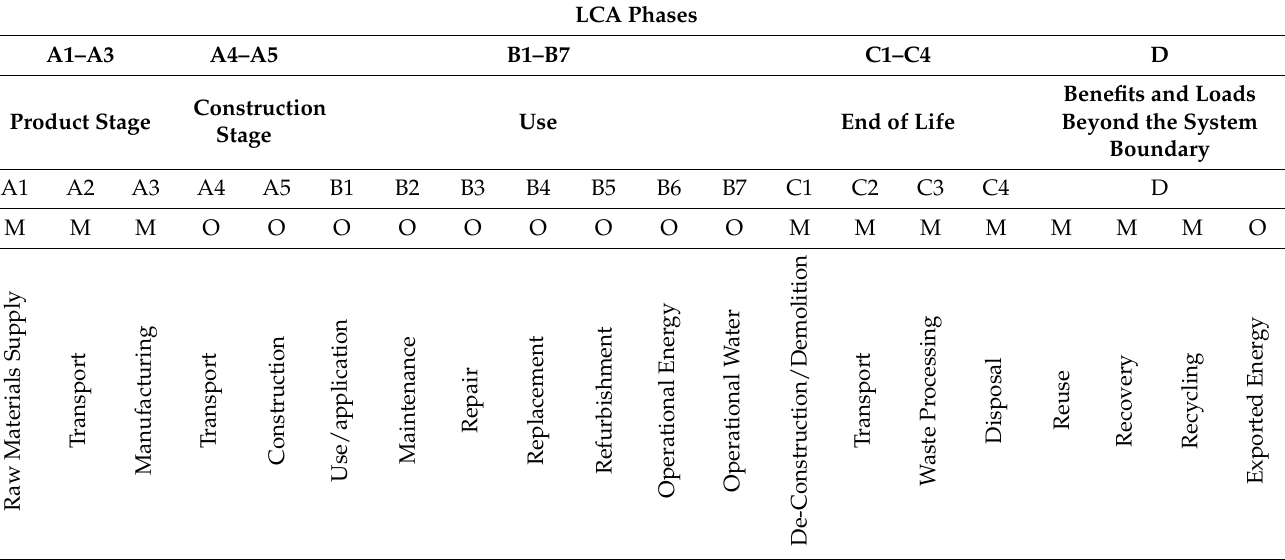
Table 1. Complete phases of the LCA analysis [41]. M = mandatory; O =